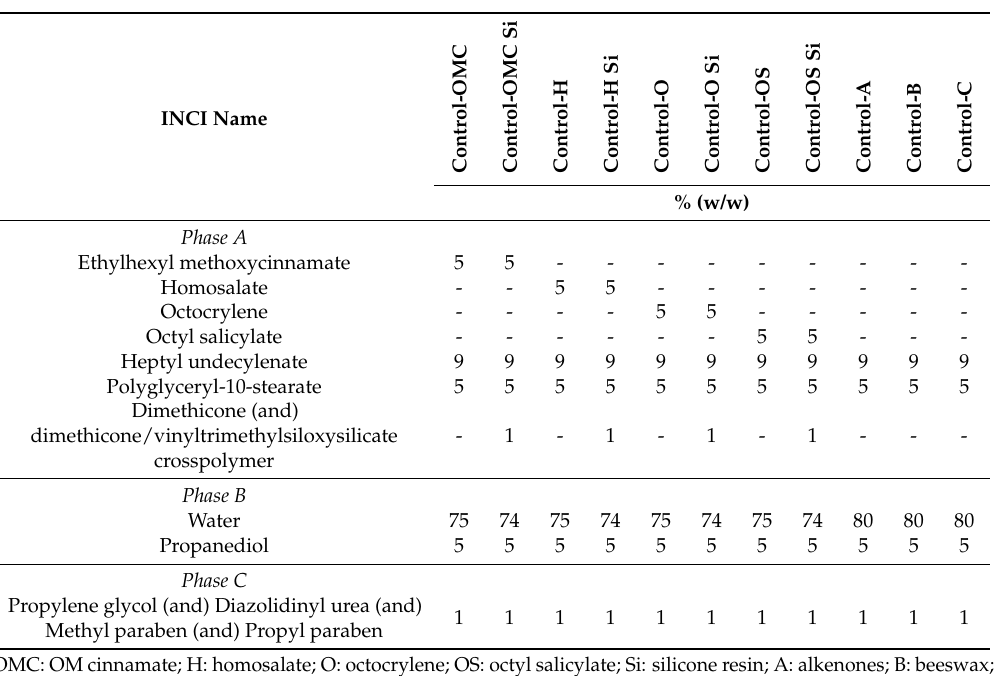
Table 2. Control sunscreen